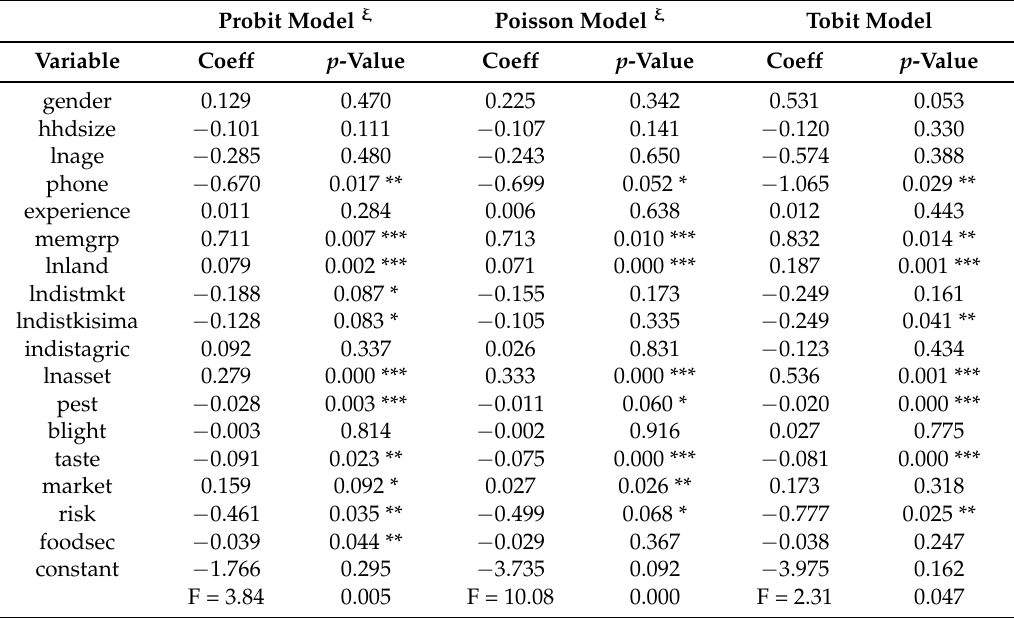
Table 3. Factors influencing the decision to use and the extent of use of certified seed potato